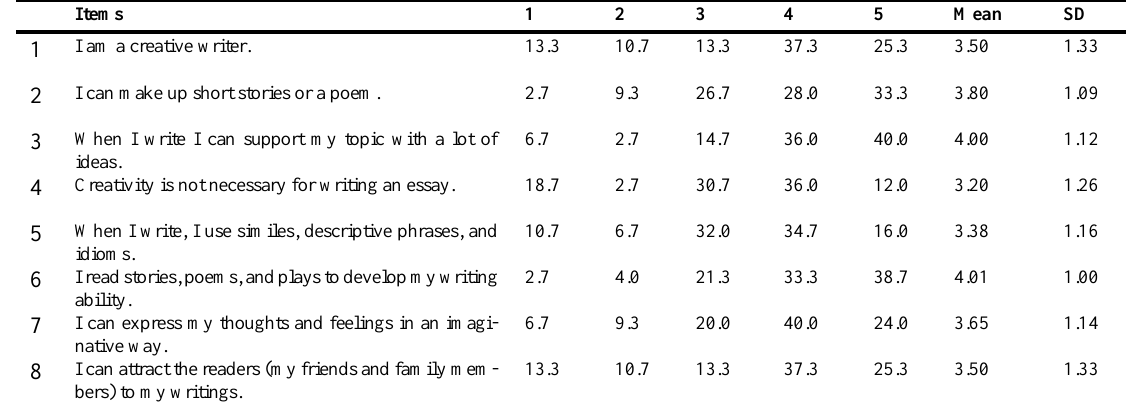
Table 5. Attitudes towards creative writing in